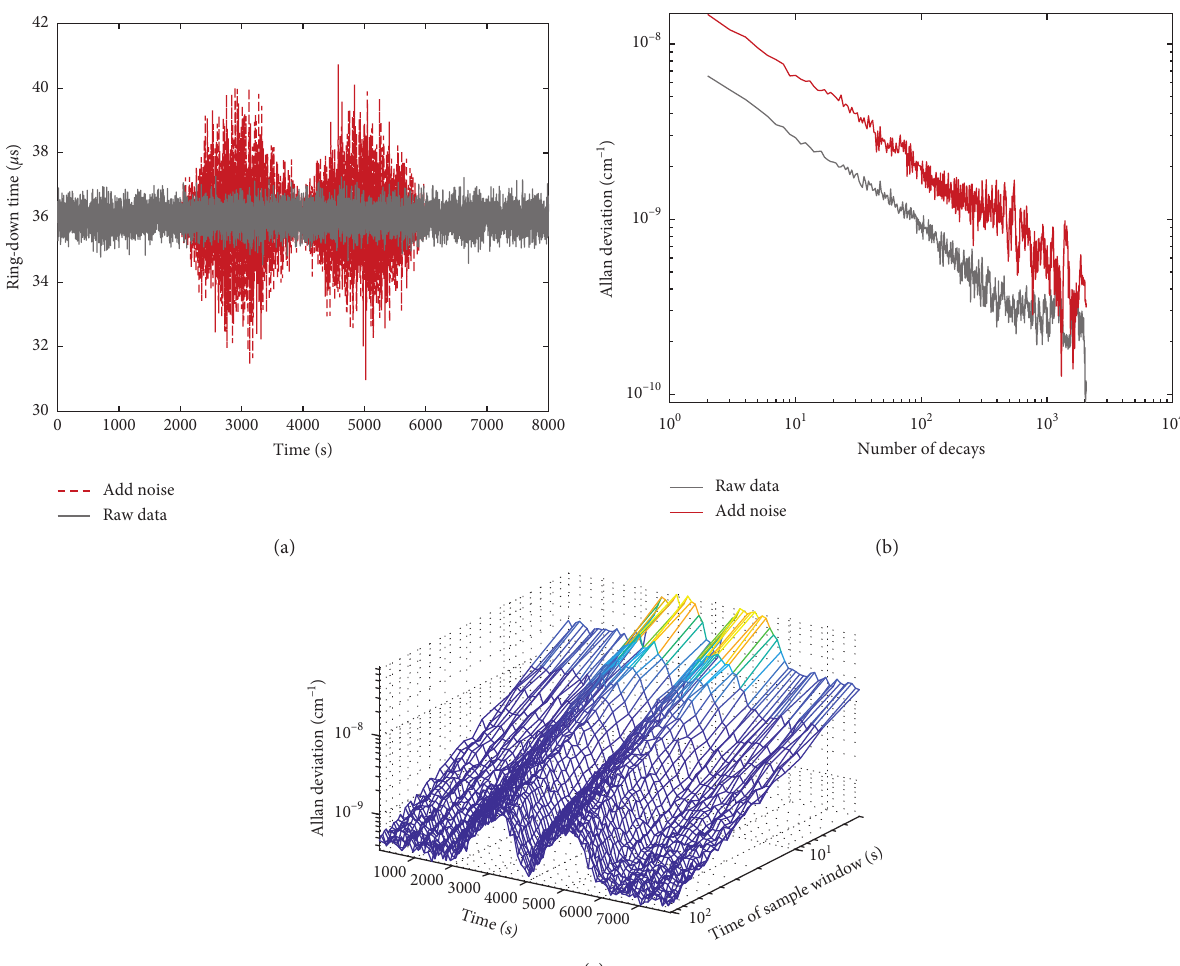
Figure 1: Allan variance and DAVAR analysis of modulated signals. (a) Add sinusoidally modulated Gaussian noise to the ring-down time series. (b) Using Allan variance to analyze the effect of noise on detection accuracy. (c) DAVAR analysis detection accuracy changes over